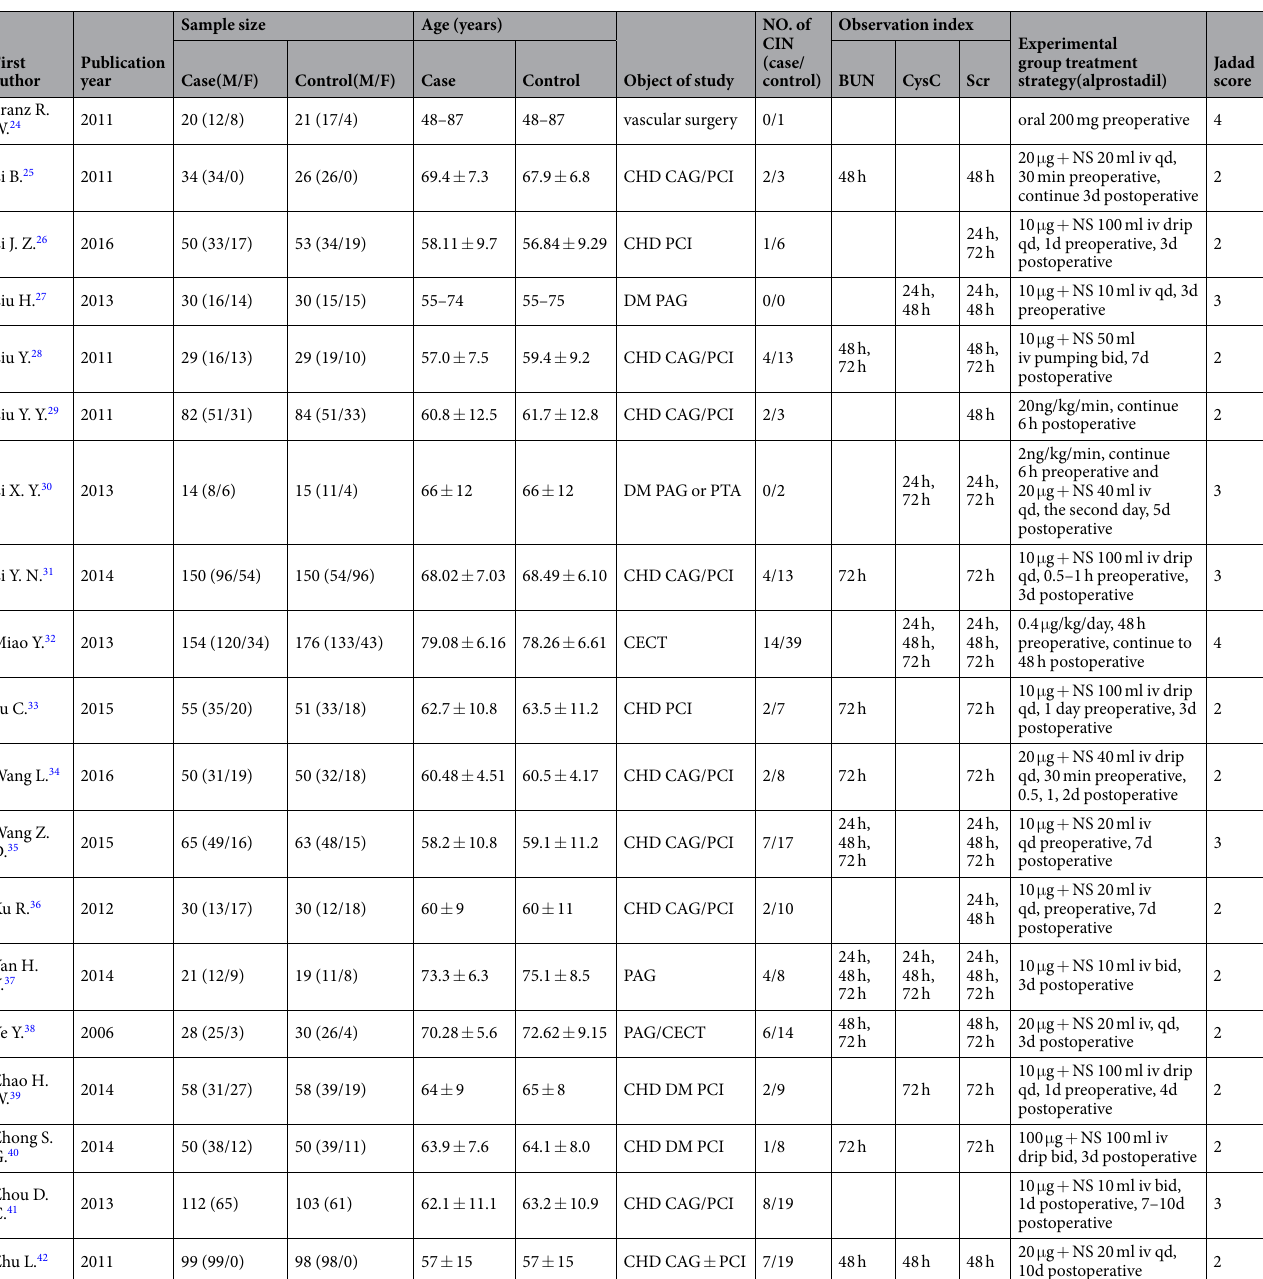
Table 1. The characteristics of include studies. CHD Coronary heart disease; DM diabetes mellitus; CAG coronary angiography; PCI percutaneous coronary intervention; PAG peripheral angiography; PTA percutaneous transluminal angioplasty; CECT contrast-enhanced computerised tomography;M male; F female; NS normal saline; d day; h hour; min minute; iv intravenous